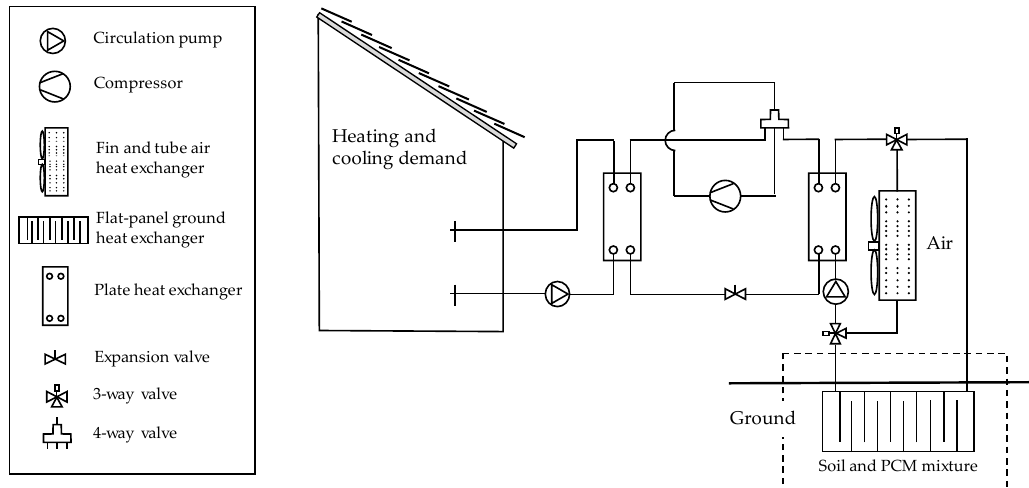
Figure 1. Layout of the dual source heat pump (DSHP) system coupled with a flat-panel horizontal ground heat exchanger (HGHE). Table 1. Physical properties of backfill materials (within trench) and surrounding ground. PCM = phase change material.